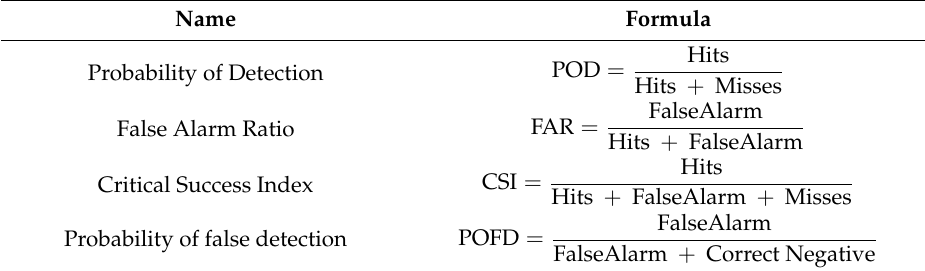
Table 3. Formulas for performance measurements based on Probability of Detection (POD), False Alarm Ratio (FAR), Critical Success Index (CSI) and Probability of false detection (POFD).